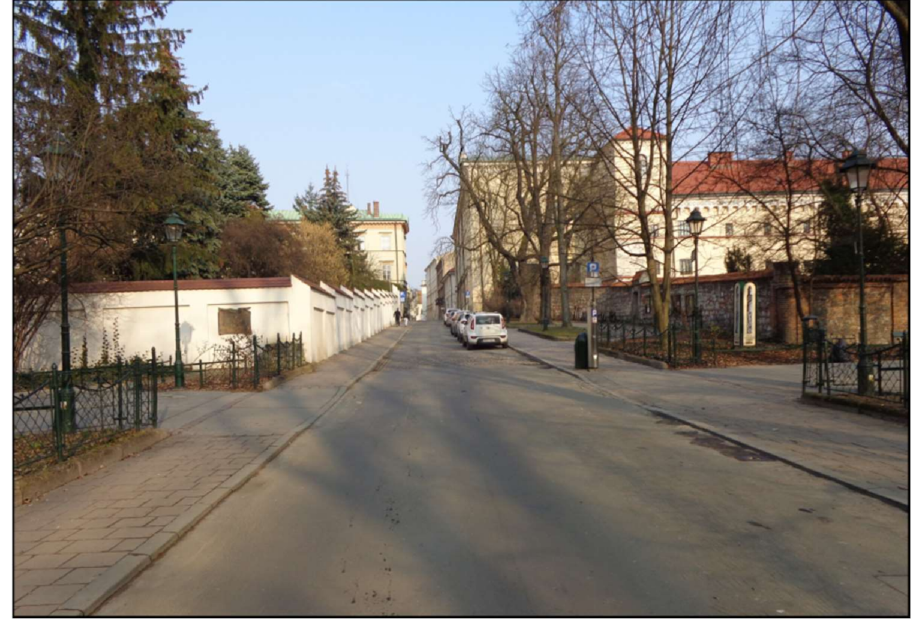
Figure 12. Convex landforms on Holocene alluvial plain: ( A )—fronton of Marshal J ó zef Piłsudski Bridge (5 m high); ( B )—overlook hillock in Jordan Park (10 m high). March 2021. Photos by R.